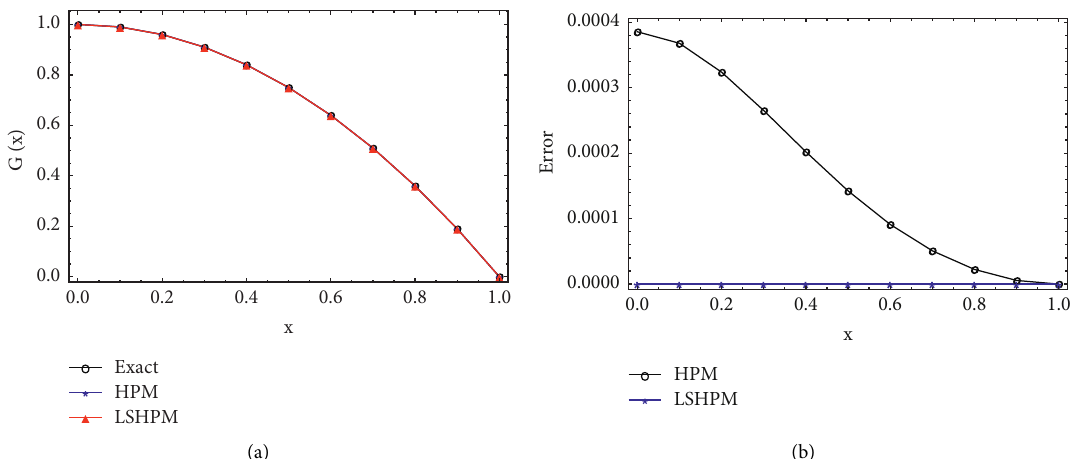
Figure 4: Graphical representation of solutions and errors in Problem 4. (a) Comparison of Exact, HPM, and LSHPM solutions. (b) Comparison of absolute errors of HPM and LSHPM.